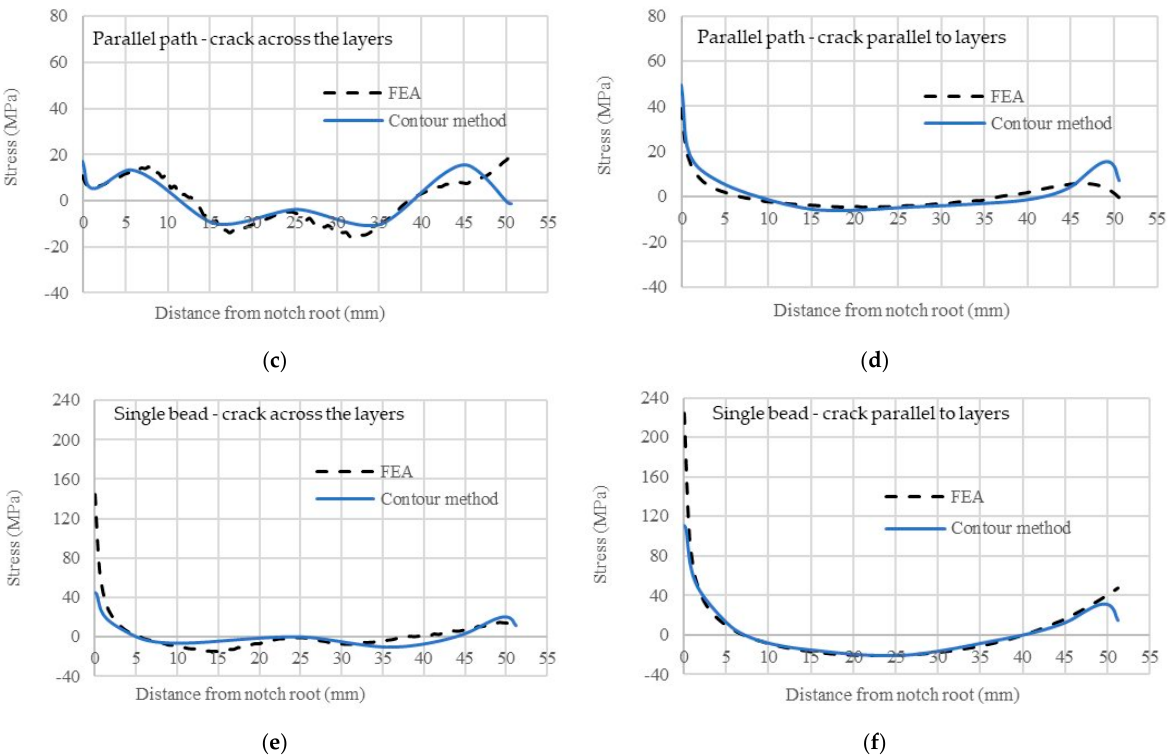
Figure 12. Comparison of residual stress profiles obtained from FEA and contour method for compact-tension (C(T)) specimens; build method and crack orientation are labled in the figures ( a – f ).